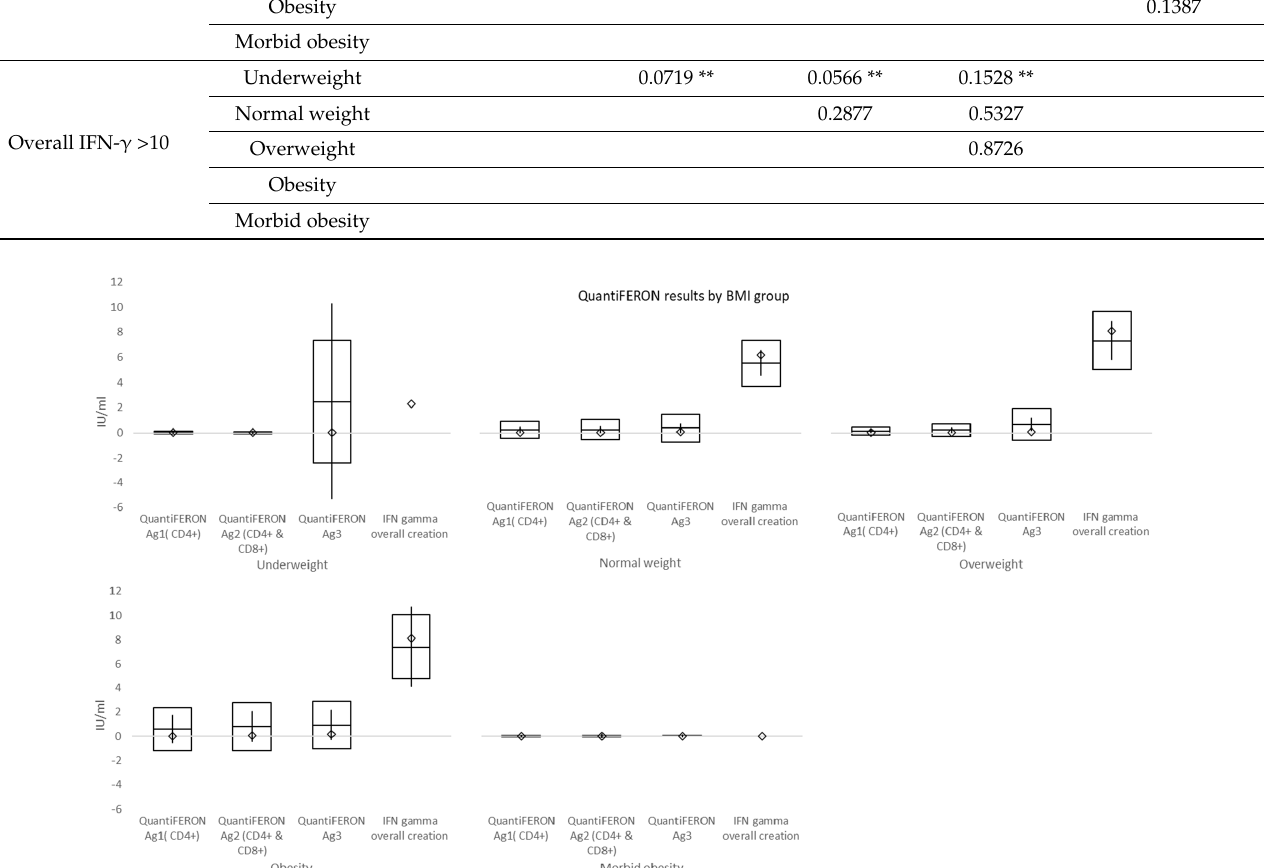
Figure 8. QuantiFERON results by body mass index (BMI) groups. Mean values of QuantiFERON Ag1 activating CD4+ T cells, QuantiFERON Ag2 activating both CD4+ T cells and CD8+ Natural killer cells, and QuantiFERON Ag3 activating CD4+, CD8+, and CD16+ (both T and B cells) were higher than cut-off (0.15–0.20 IU/mL). Overall interferon- γ (IFN- γ ) >10 IU/mL was shown in 63.8% of subjects. T cells were significantly less activated in morbid obesity compared to both normal weight and overweight individuals. □ mean ± standard deviation; ◊ median; │ minimum − maxi- mum.